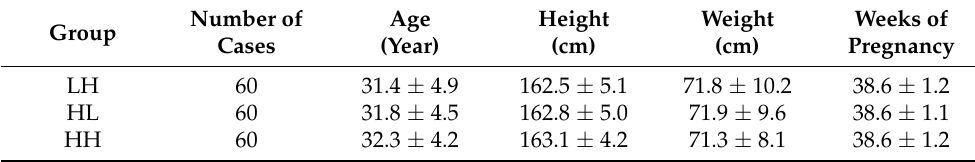
Table 1. Comparison of general characteristics of three groups.